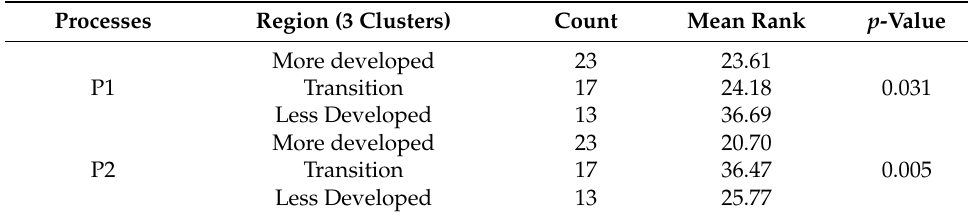
Table 6. Results of Kruskal–Wallis test.